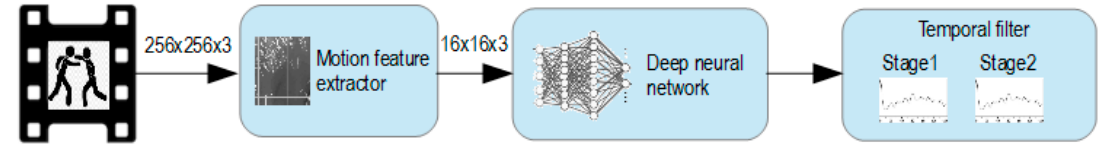
Figure 1. The main steps of the algorithm running on a sensor node.